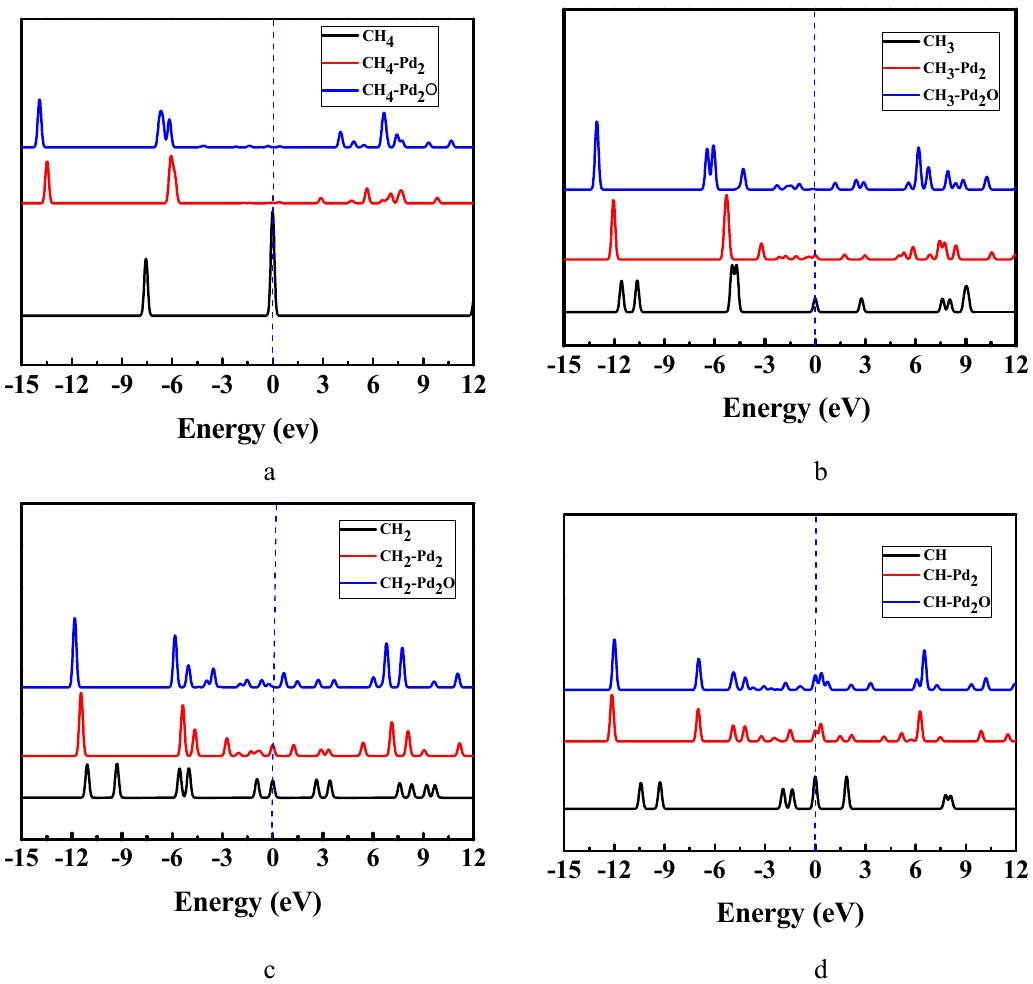
Figure 3. Partial density of states (PDOS) of CHx (x = 1–4) before and after being catalyzed by Pd 2 and Pd 2 O. ( a – d ) CH 4 , CH 3 , CH 2, and CH, respectively, before and after being catalyzed by Pd2 and Pd 2 O. Black, red, and blue lines, free CHx and CHx–Pd 2 (O), respectively. The blue dashed vertical lines indicate the Fermi levels .